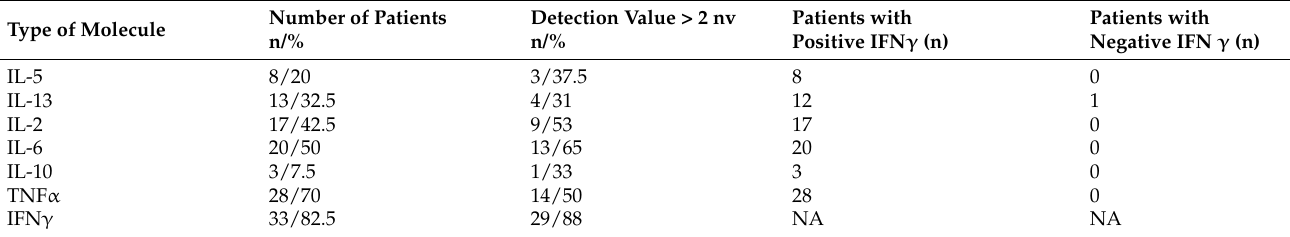
Table 3. Distribution of the cytokine profile in the serum of pSS